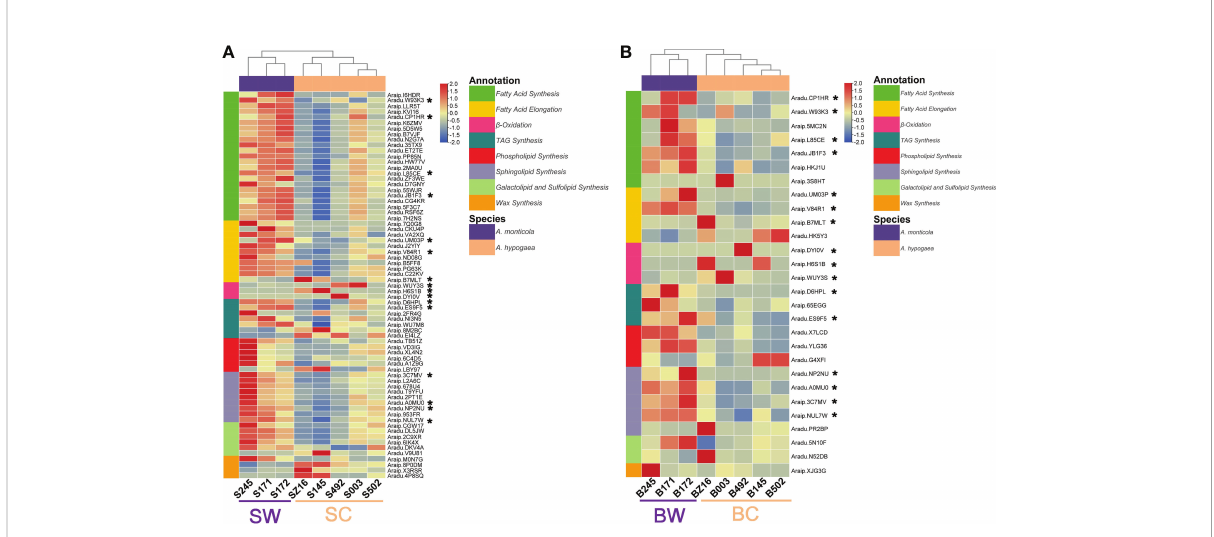
FIGURE 3 Heatmaps of lipid metabolism-related DEGs between wild and cultivated peanuts. Panels (A) and (B) represented the R5 and R8 stages, respectively. * denoted the differentially expressed genes identi fi ed at both stages. SW and SC indicated seeds of wild and cultivated peanuts at the R5 stage, respectively. BW and BC denoted seeds of wild and cultivated peanuts at the R8 stage,